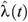
Reconstruction of the rate modulation index.(A) Reconstruction of the rate function of a single GPi neuron. Top—1 second from the neuron's spike train. Middle—power spectrum of the spike train, presenting a peak at ~14 Hz. Bottom—the reconstructed rate function λ^(t). (B) The analytically reconstructed rate modulation index (m^), as a function of the estimated baseline firing rate (r^0). The solid lines indicate the mean estimated modulation; the shaded areas indicate ±1 STD of the reconstructed modulation, and the dashed line indicates the original modulation. (C) The modulation index detection. The significance level was set according to the simulation results in B; i.e., the mean result for the modulation index of zero at a specific firing rate + 2 STDs. (D) Comparison of the difference between the detections by the modulation index and the spectral peak. (E) Reconstruction of the modulation index of GPi neurons. The results are shown for 98 (of 229) neurons that had a modulation index greater than zero (R2 = 0.02, p > 0.1).